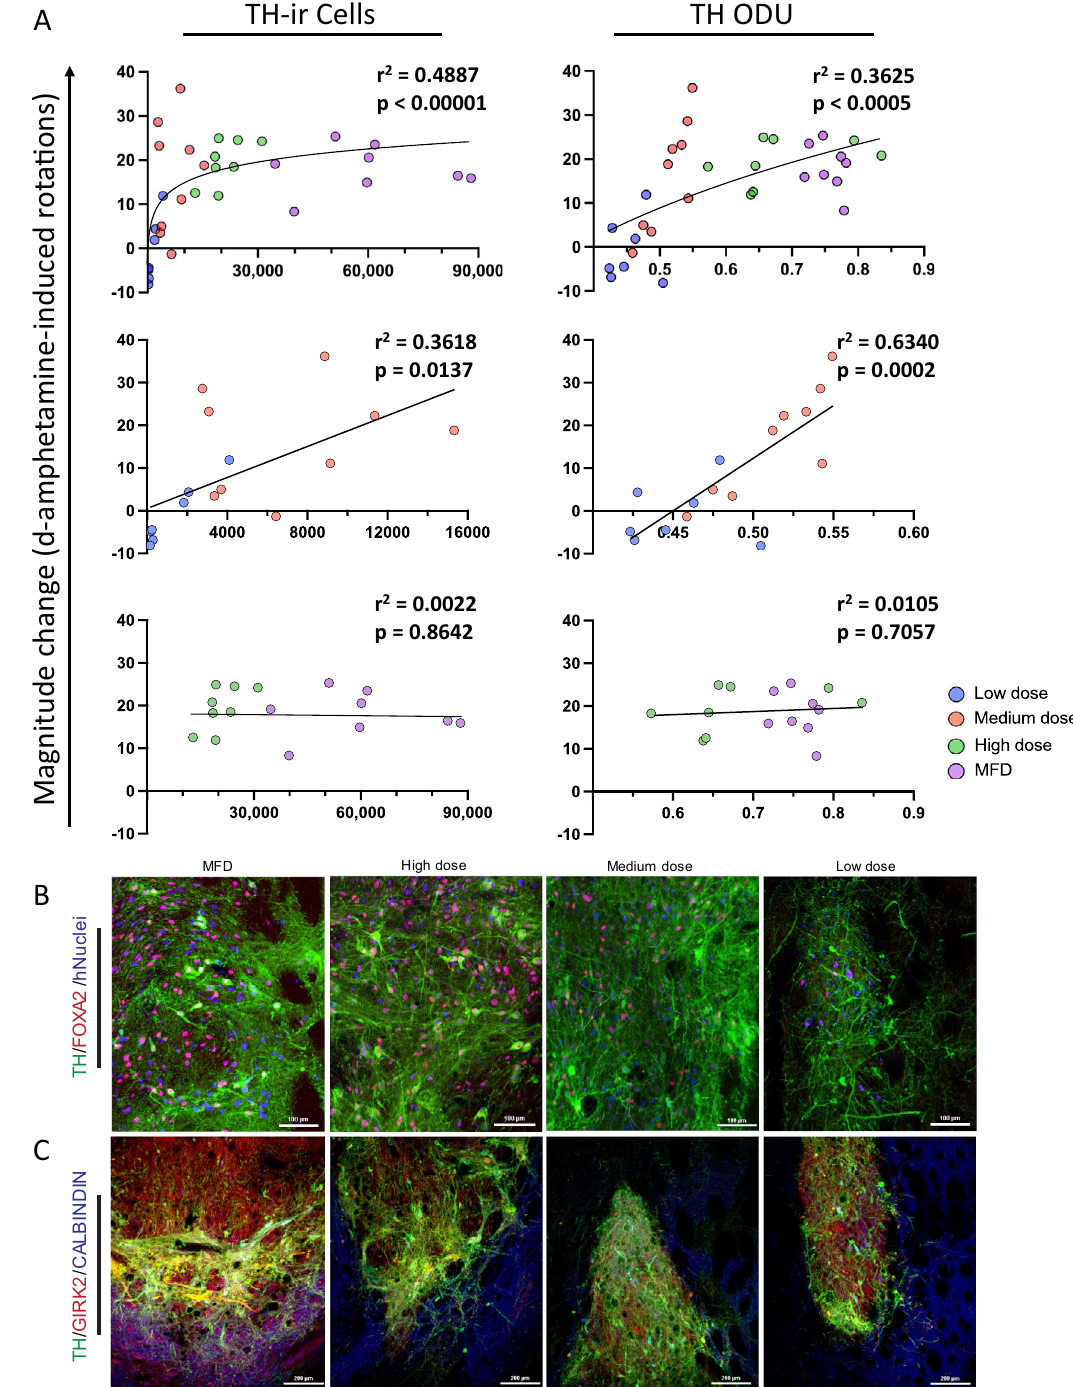
Fig. 7 Correlations of dopaminergic phenotype with behavioral recovery and visualization of mDA subtype. A Estimated number of TH-ir cells and TH optical densitometric measurements plotted against the absolute value of the magnitude of change in net d-amphetamine- induced rotations and fi tted with logarithmic regression curve. Linear regression for low/medium or high/ “ maximum feasible ” doses and behavioral recovery. Representative images containing grafts of low, medium, high, and “ maximum feasible ” dose for immuno fl uorescent triple-labeled B hNuclei/TH/FOXA2 (blue/green/red) and C TH/GIRK2/Calbindin